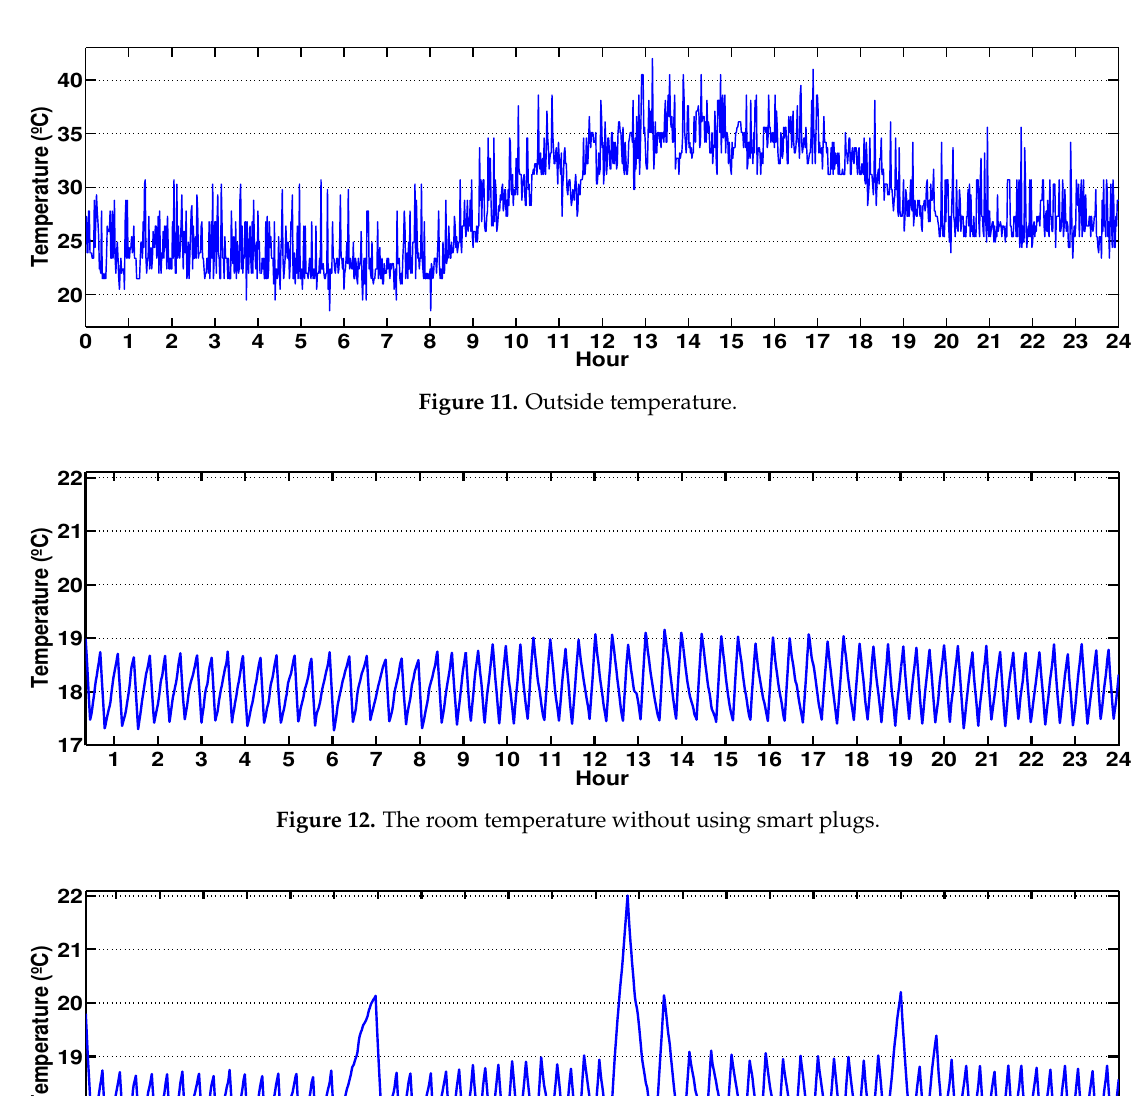
Figure 13. The room temperature while utilizing the smart